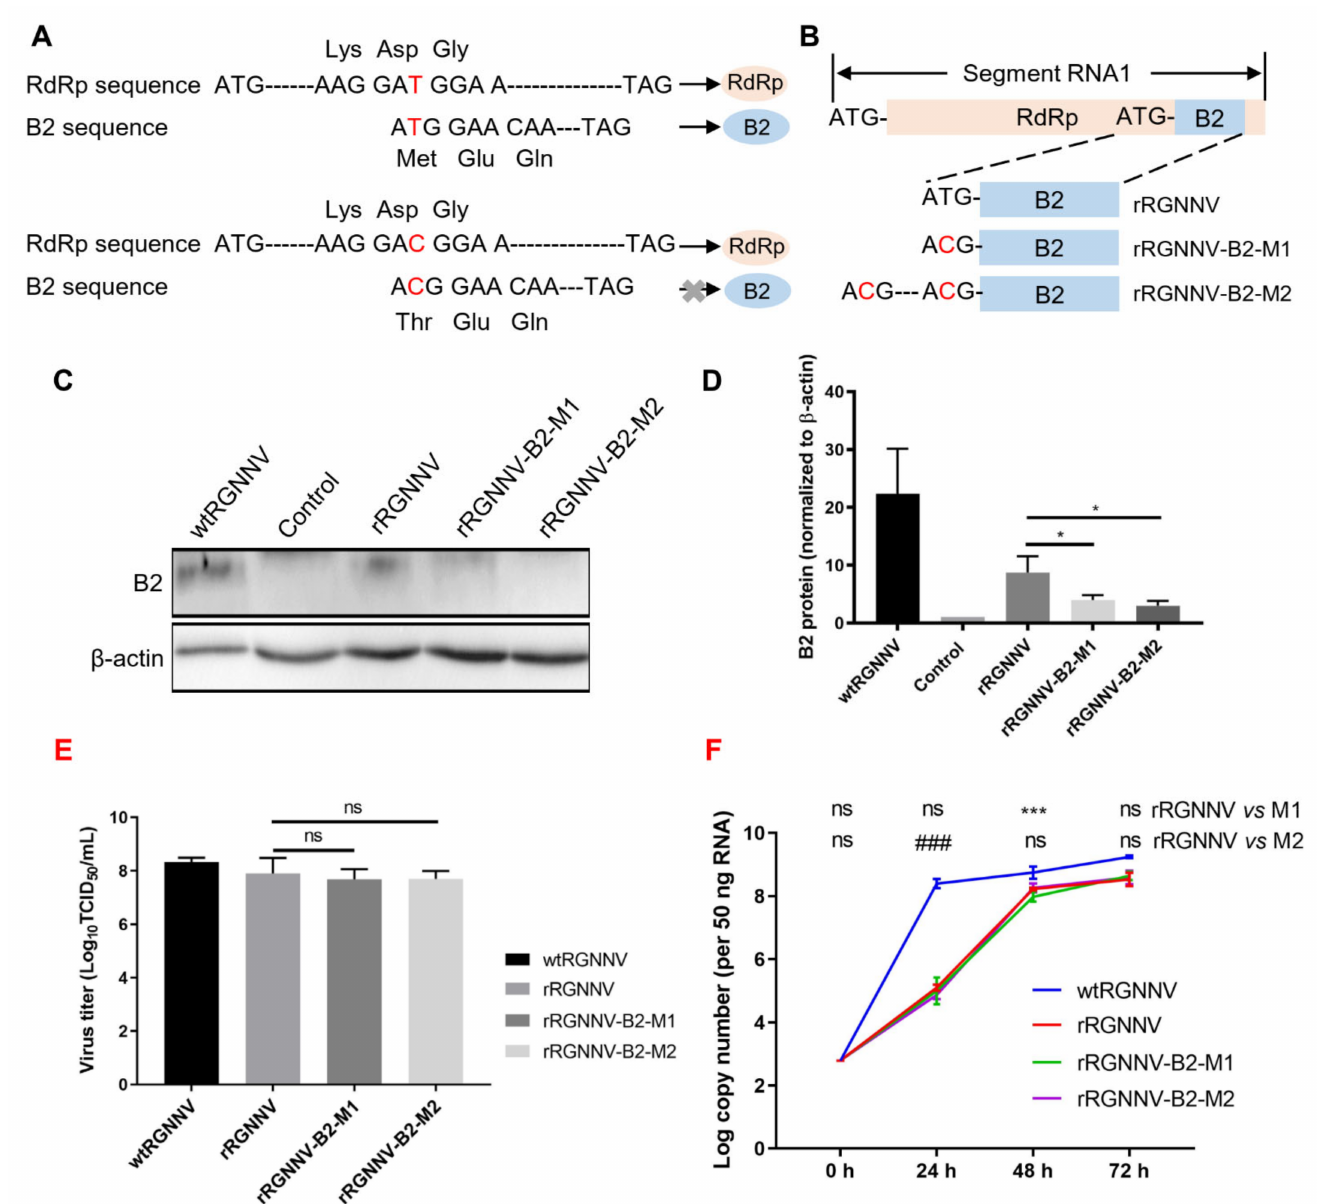
Figure 2. Construction of rRGNNV-B2-M1 and rRGNNV-B2-M2 viruses. ( A , B ) Schematic repre- sentation of the construction of pRGNNV-T7-RNA1-B2-M1-CMV-eGFP and pRGNNV-T7-RNA1- B2-M2-CMV-eGFP. ( C , D ) B2 expression detected by Western blotting. B7GG cells were transfected with plasmid pRGNNV-T7-RNA1-CMV-eGFP, pRGNNV-T7-RNA1-B2-M1-CMV-eGFP or pRGNNV- T7-RNA1-B2-M2-CMV-eGFP for 36 h. SSN-1 cells infected with wtRGNNV directly were used as positive control. Blank cells were used as negative control. B2 was detected by Western blotting, β -actin was used as the internal control. ( E ) The virus titer of wtRGNNV, rRGNNV, rRGNNV-B2-M1, and rRGNNV-B2-M2 was measured using TCID 50 . Both supernatants and SSN-1 cells were collected at 72 hpi for viral titration. ( F ) Viral replication kinetics of recombinant RGNNV. SSN-1 cells were infected with 5 MOI of wtRGNNV, rRGNNV, rRGNNV-B2-M1, and rRGNNV-B2-M2, respectively. Cells were collected at 0, 24, 48 and 72 hpi for viral Cp RNA detection by RT-qPCR. Data shown in ( D – F ) are mean ± SD of three independent experiments. * p < 0.05; *** p < 0.001; ### p < 0.001; ns, not significant; both by Student t-test. All experiments were performed in